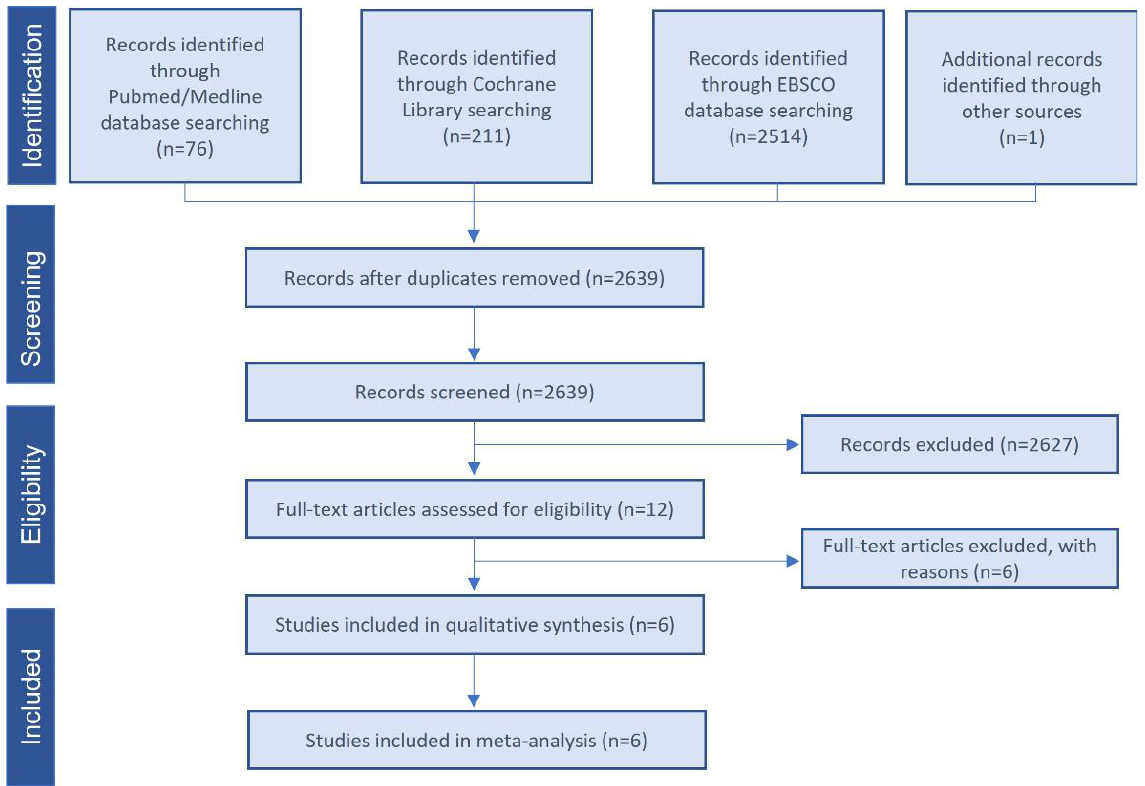
Figure 1. Study selection flow diagram. PRISMA flow diagram of the screening and selection pro- cess.